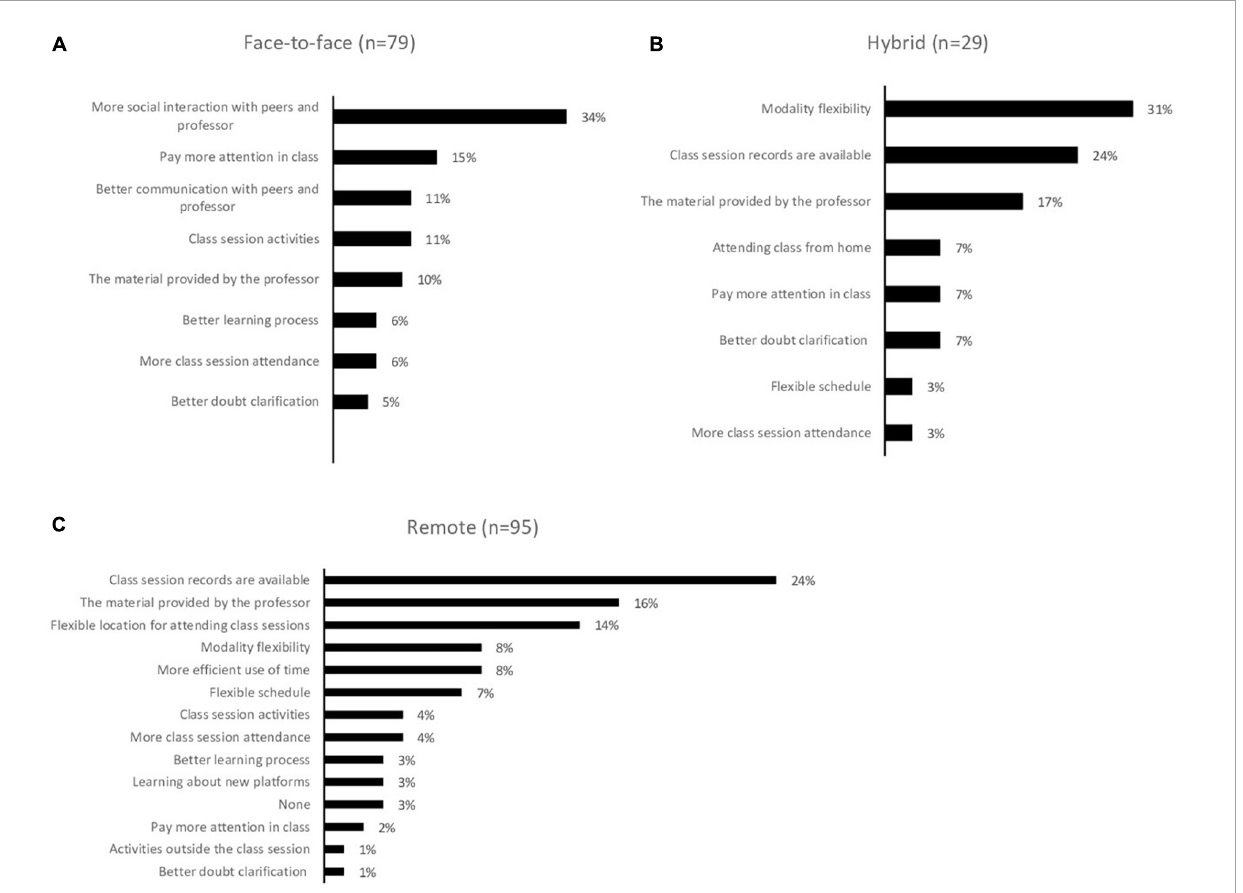
FIGURE1 Perceived factors fostering learning in each modality: face-to-face (A) , hybrid (B) , and remote (C)